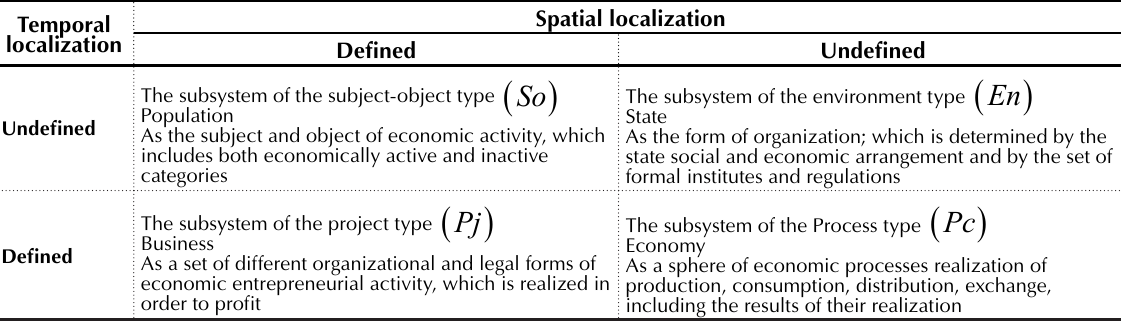
Table 1. Distribution of the elements of country’s socio-economic system by the subsystems and their systemic